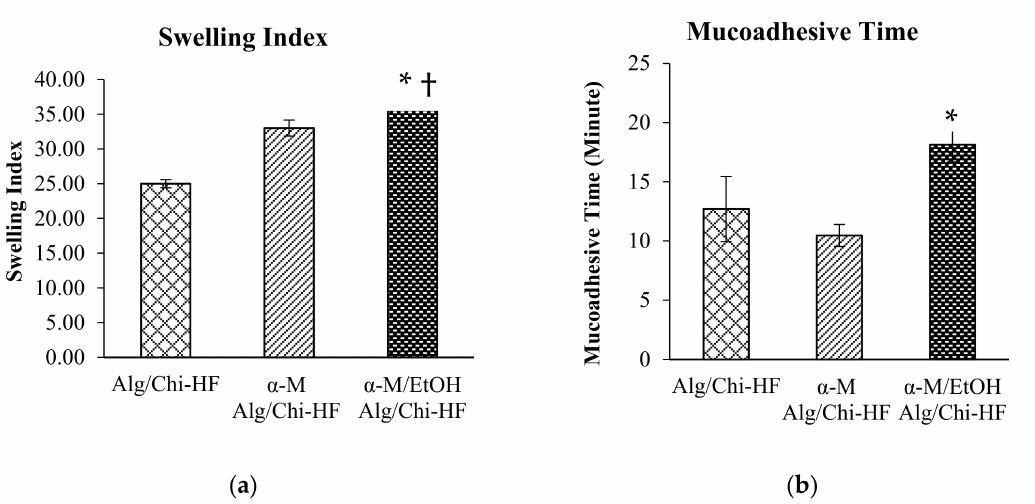
Figure 4. Swelling index ( a ) and mucoadhesive time ( b ) of Alg/Chi HF, α -M Alg/Chi HF, and α -M/EtOH Alg/Chi HF. The results are expressed as the mean ± SD ( n = 3). † p < 0.0001 and * p < 0.05 compared to